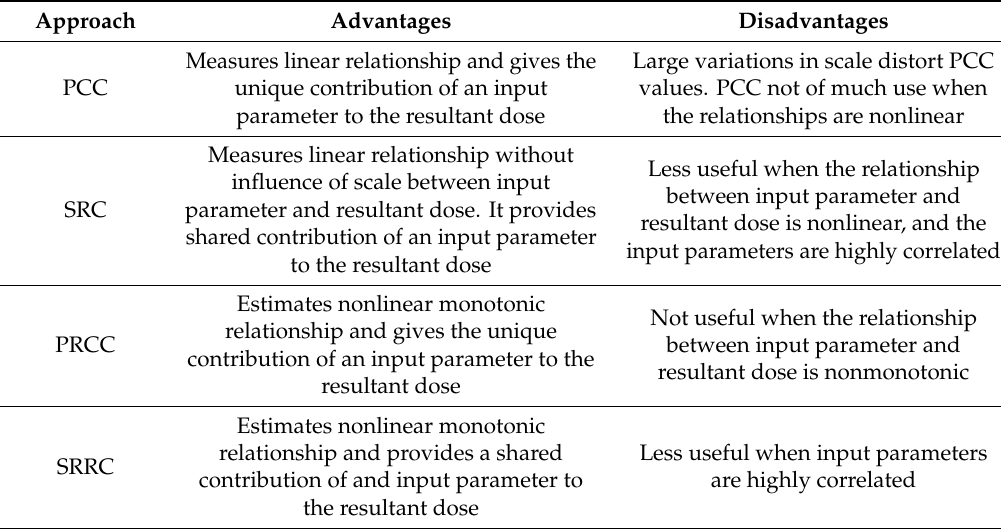
Table 2. Comparison of correlation coe ffi